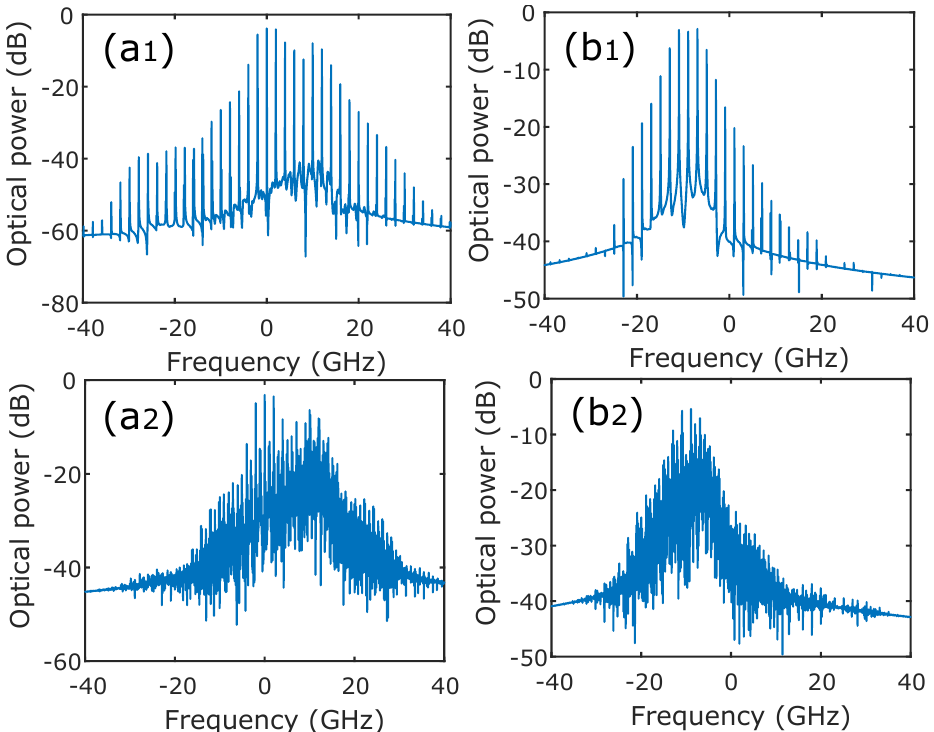
Figure 10. Optical spectra for fixed Ω = 2 GHz, ∆ ν x = − 9 GHz and γ a = − 0.6 ns − 1 . The left ( a ) and right ( b ) panels correspond to X-PM and Y-PM, respectively. The top figures ( a 1 , b 1 ) are obtained for κ = 0.525 and the bottom figures ( a 2 , b 2 ) are obtained for κ = 0.6 .